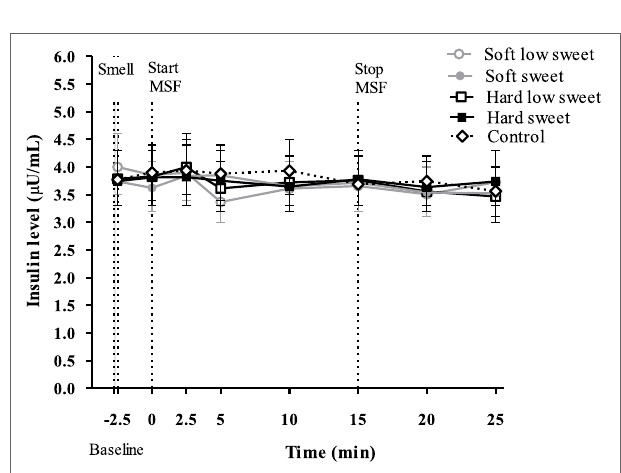
FigUre 5 | Geometric mean ± 95% CI insulin ( μ U/ml) concentrations over time per treatment and control condition. No significant differences were found between treatments and control condition at any of the time points ( p = 0.97).